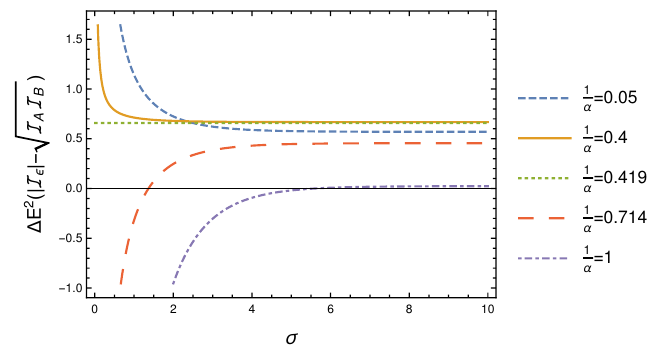
√ (cid:0) (cid:1) is plotted for two anti-parallelly |I ε | − I A I B = α . A B